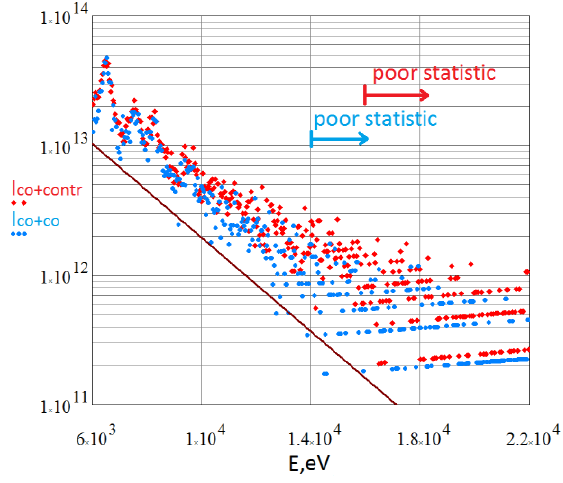
Fig. 12. •X-ray spectrum (#73111- co+contr, red circles), •X- ray spectrum (#73117- co+co, blue